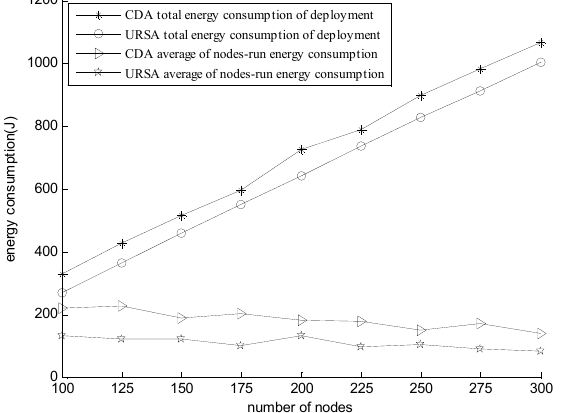
Figure 15. Comparison of energy consumption for varying numbers of sensor nodes (the unit of deployment energy consumption is 10 3 J).